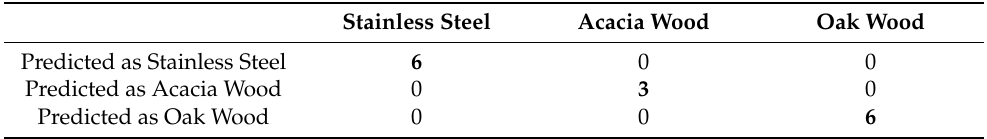
Table 4. Classification of white variety (Vilana, 2012 vintage) concerning the container type with